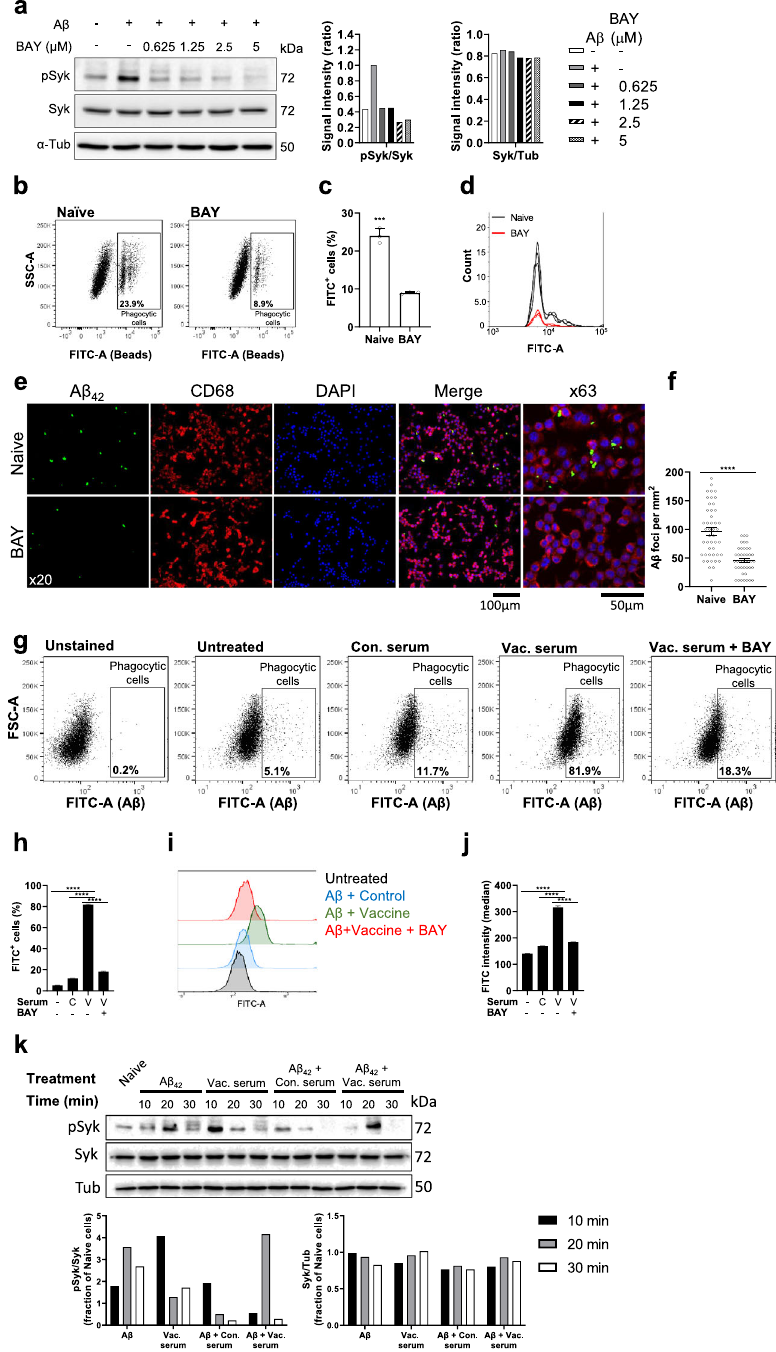
Fig. 9 Maternal antibodies mediate A β phagocytosis by N9 microglial cell-line in a Syk-dependent manner. Phagocytosis capacity and intracellular signaling were assessed in N9 murine embryonic cell-line following treatment with either A β 42 alone or A β 42 pre-incubated with serum from anti-A β or sham-vaccinated dams. The contribution of Syk signaling was assessed using Syk inhibition by BAY-61-3606. a BAY inhibits Syk phosphorylation in a dose- dependent manner. b – d Phagocytosis of FBS-coated fl uorescent beads by N9 cells is reduced following treatment with Syk inhibitor. e , f IF of N9 cells following incubation with A β reveals a reduction in phagocytosis capacity after Syk inhibition. g – j Serum from anti-A β vaccinated dams increases phagocytosis by N9 cells compared with serum from sham-vaccinated dams and abrogation of this effect following Syk inhibition. k Treatment with A β , serum from anti-A β or sham-vaccinated dams, or combined treatment reveals differences in the time-course of Syk phosphorylation. *** P < 0.001, **** P < 0.0001, unpaired t-test, Chi-squared test for independence, Fisher ’ s exact test, one-way ANOVA, data are presented as mean ± SEM.